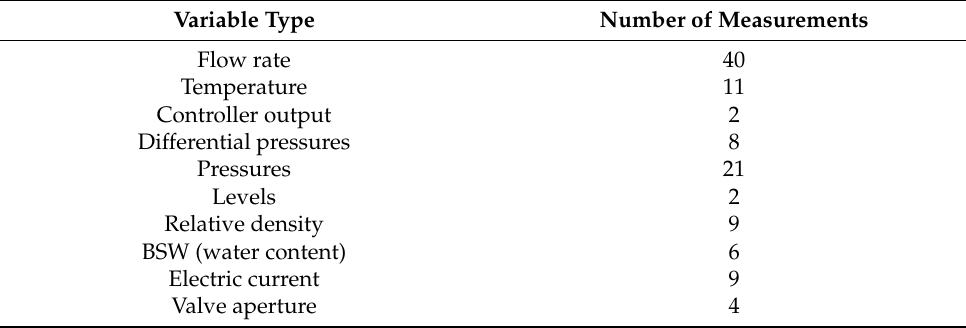
Table 2. Variable measurements in the gas-oil metering station (see Figure 1).